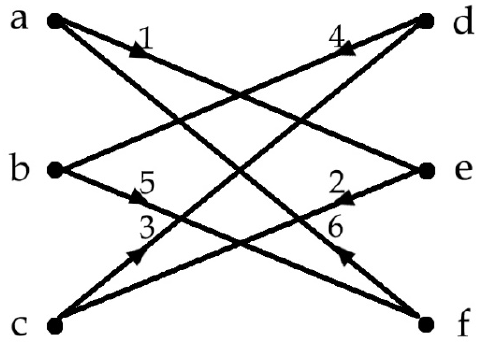
Figure 4. Exploring neighboring cliques in a cognitive